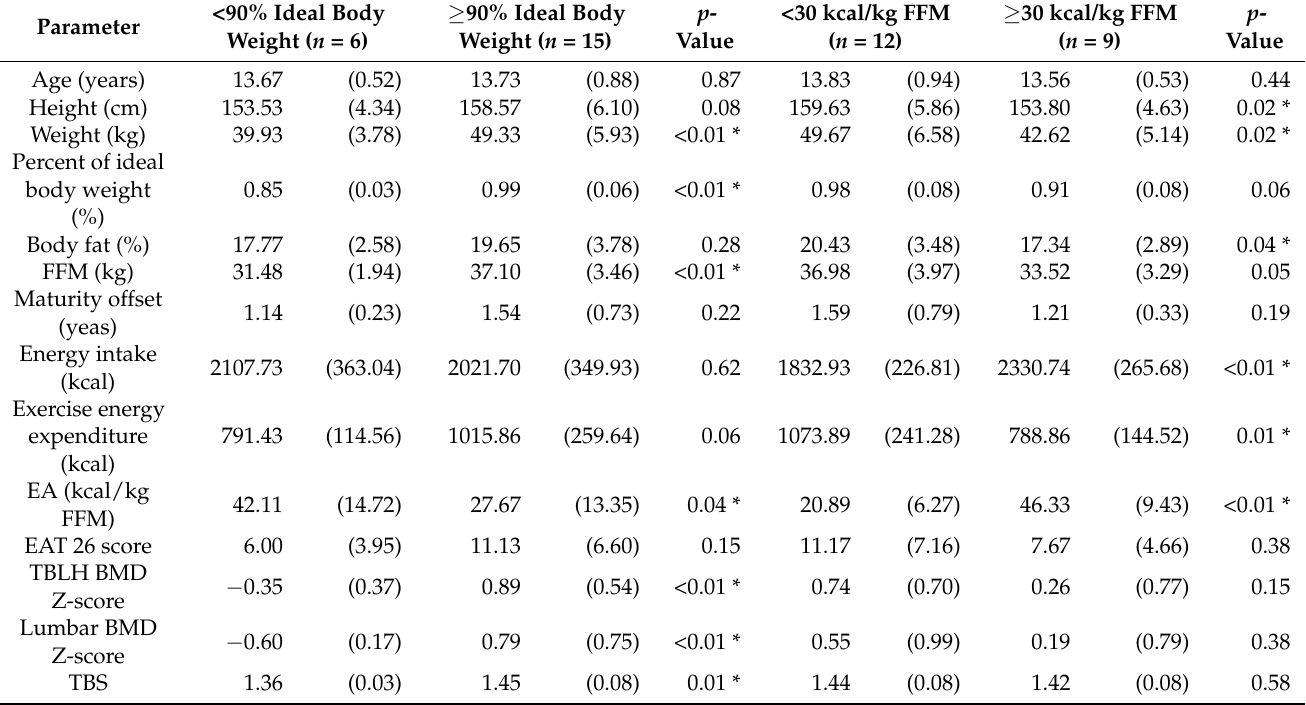
Table 2. Characteristics of participants divided into LEA